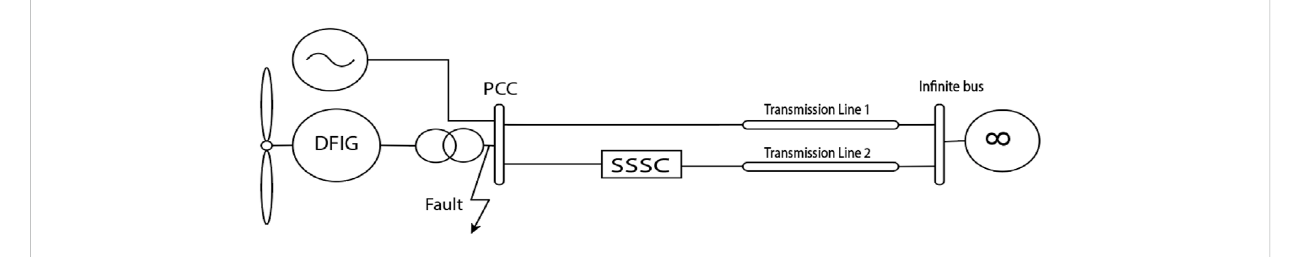
FIGURE 1 Block diagram of the proposed system.